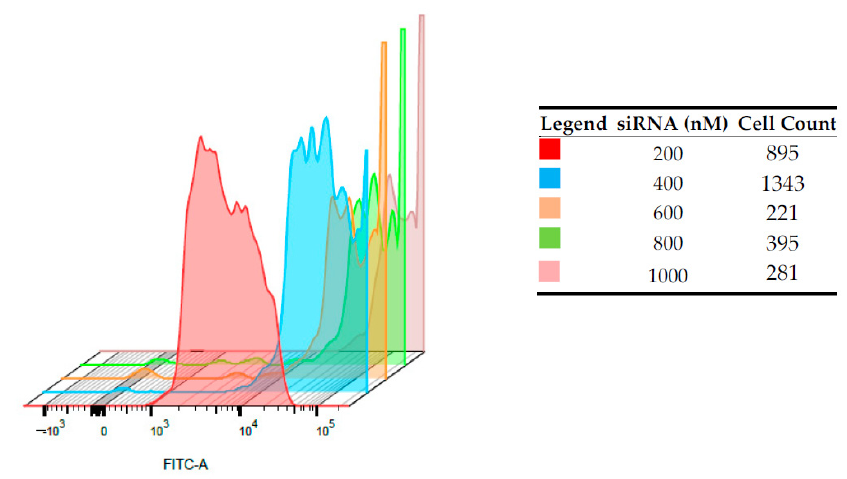
Figure 6. Intracellular fluorescence intensities on PBMCs of FITC-siRNA/CS-NPs complexes pre- pared at different siRNAs concentrations, determined by flow cytometry.